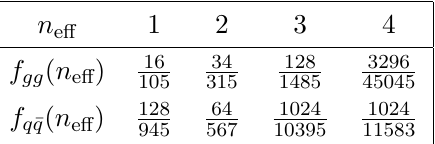
, of the partonic luminosities on the system eff